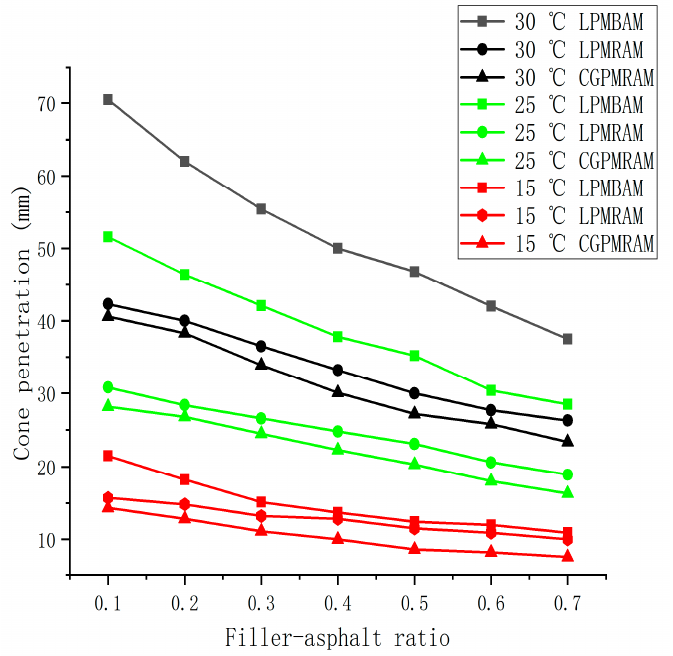
Figure 5. Cone penetration histogram at di ff erent temperatures and fi ller-asphalt ratios.